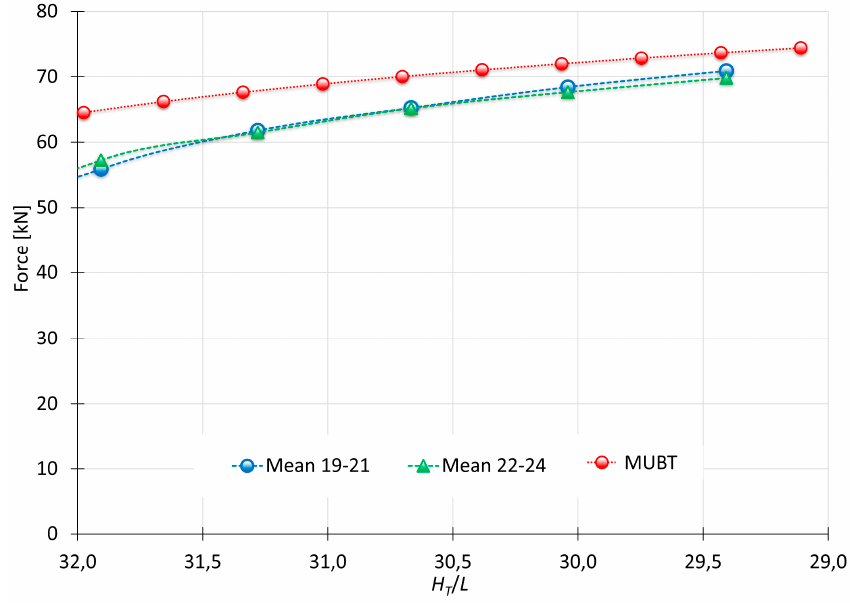
Figure 17. Comparison between MUBT and Experimental tests.